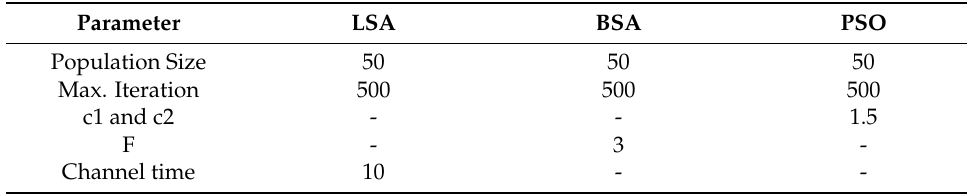
Table 4. Boundary settings utilized in each optimization